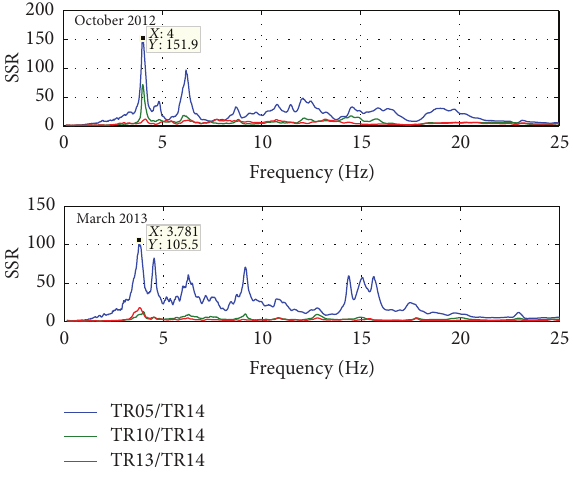
Figure 9: Amplitude spectral ratios derived for the crest stations using S13 seismometers time-recordings with 43-metre water level height.